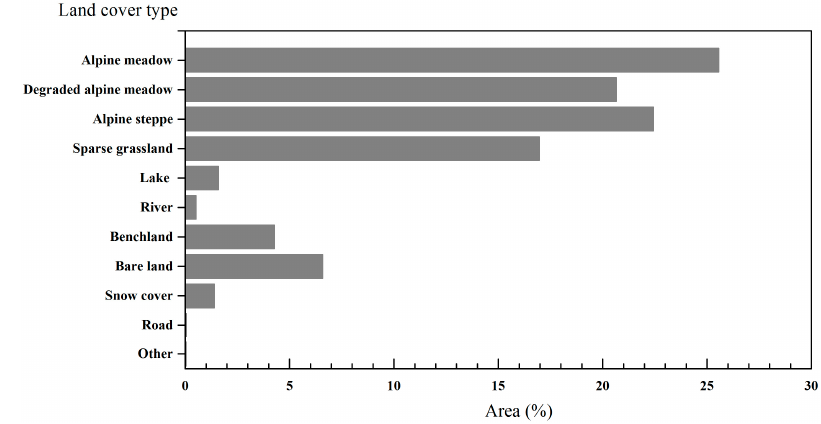
Figure 3. Statistics of distribution of the land cover types over the study area. Remote Sens. 2018 , 10 , x FOR PEER REVIEW